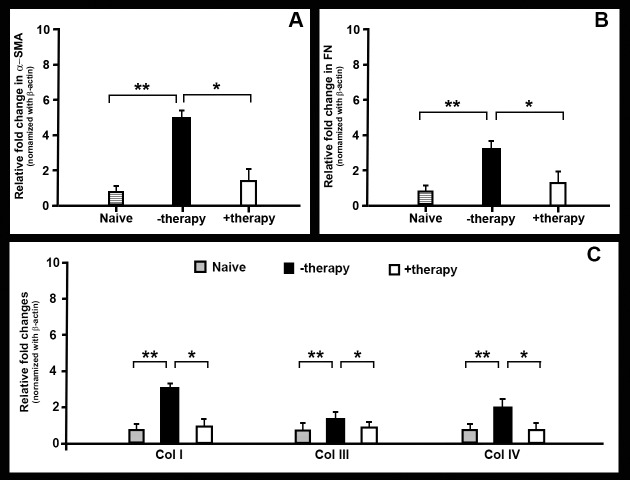
Bar graphs showing differential mRNA expression of (A) α-SMA, (B) fibronectin (FN), and (C) collagen I (Col I), collagen III (Col III), and collagen IV (Col IV) in the corneal tissue from rabbits in the naive, PEI2-GNP (−therapy), and BMP7+HGF (+therapy) groups. Tissue was obtained 21 days after injury. BMP7+HGF treatment reduced fibrotic gene expression in injured cornea. Quantification of mRNA expression of fibrotic-related genes by real-time PCR. Graphs depict relative fold expression of α-SMA, fibronectin, collagen I, collagen III, and collagen IV (n = 6 for each group). Error bars represent ± SEM (**P < 0.001 against naive control and *P < 0.01 against BMP7+HGF group, respectively).